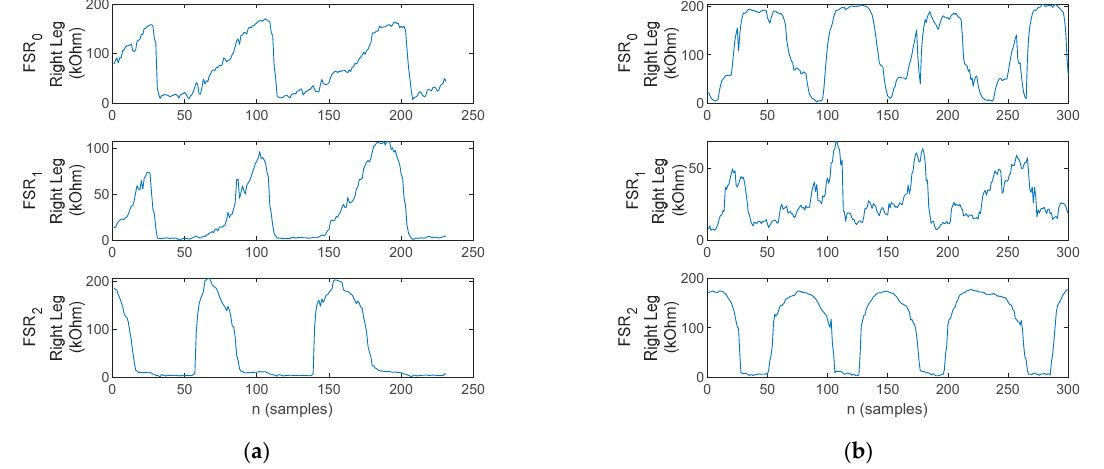
Figure 16. The FSR waveforms ( FSR 2 —heel, FSR 1 —metatarsal arch, FSR 0 —toe) during the walking trials for ( a ) healthy control—exhibits a section when no pressure is applied, thus indicating lift-off, and ( b ) Patient 3—exhibits no section when no pressure is applied, indicating that the patient does not lift the foot from the ground but rather pulls the foot during swing. The biomechanical parameters of the test group are listed in Table 2. Table 2. Biomechanical parameters of the test group.